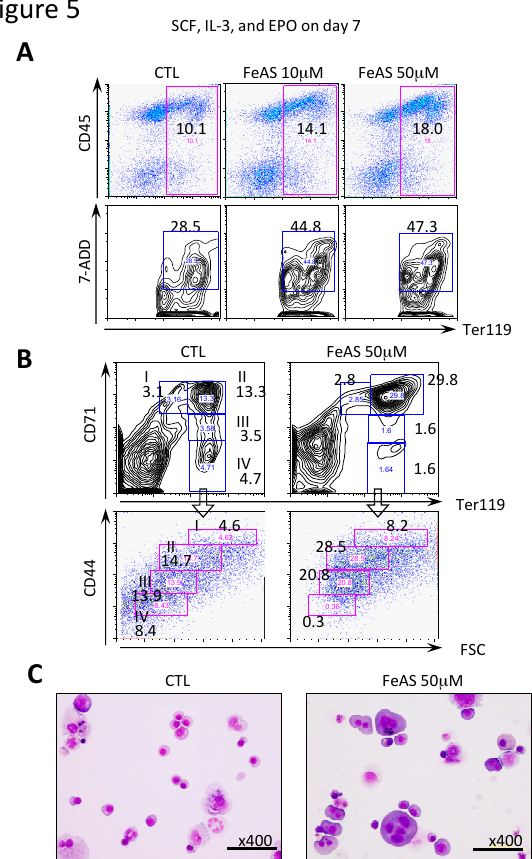
Figure 5. FeAS interferes with the development of erythroid cells with severe morphologic abnormalities. ( A ) Flk-1 + cells were induced to develop into erythroid cells using the OP9 system as described in Materials and Methods. After 7 days of culture with the indicated cytokine cocktail in the presence or absence of FeAS, the expression of CD45 and Ter119 on the cultured cells was examined by flow cytometry analysis. Apoptotic cells in the erythroid lineage were detected as Ter119 + 7-AAD + cells, and the percentage of these cells is indicated. ( B ) Erythroblasts at different maturation stages were identified by double staining with FITC-conjugated anti-TER119 and APC-conjugated anti-CD44 Abs. Plots of CD44 vs. forward scatter (FSC) for TRE119-positive cells are shown. After cells were cultured as described above, the expression of CD71 and Ter119 was examined by flow cytometry analysis. The percentages of cells in fractions I to IV are indicated. I (Ter119 low CD71 + ) corresponds to ~CFU-E; II (Ter119 + CD71 + ) to proerythroblasts; III (Ter119 + CD71 low) to erythroblasts; IV (Ter119 + CD71 − ) to erythrocytes. ( C ) After 11.5 days of culture in the absence or presence of 50 µ M FeAS, cultured cells were subjected to morphological analysis.